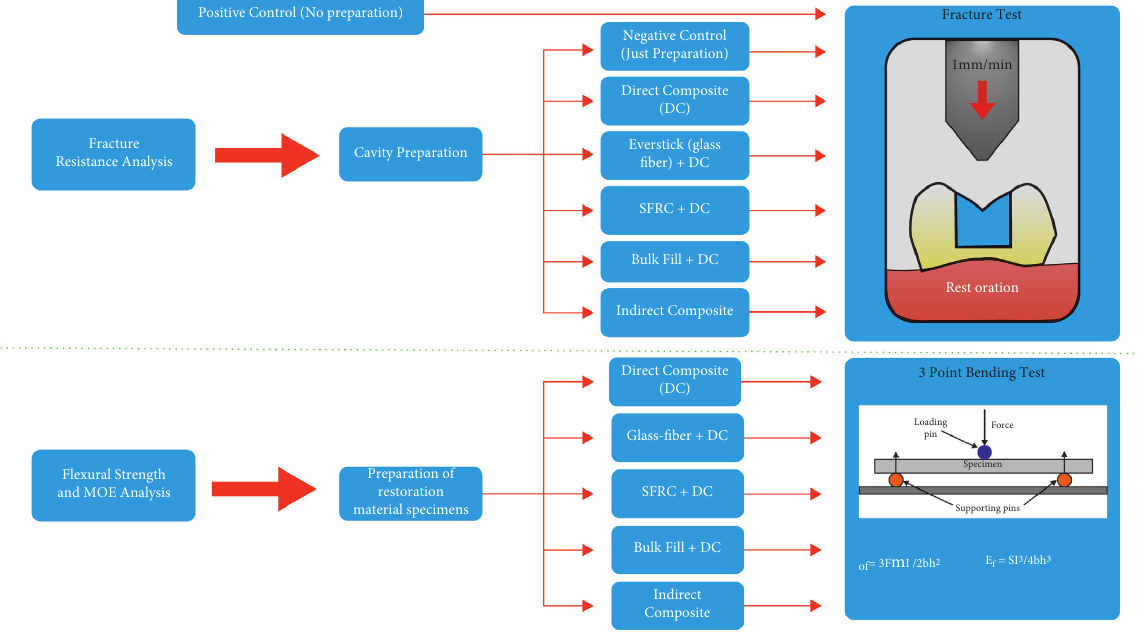
Figure 1: Schematic work flow of the